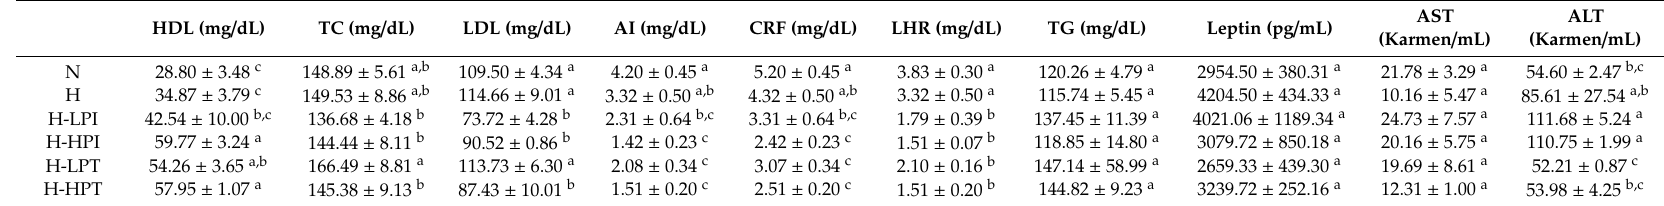
Table 4. E ff ect of PEO on the serum profile of normal diet and HFD fed male rats.